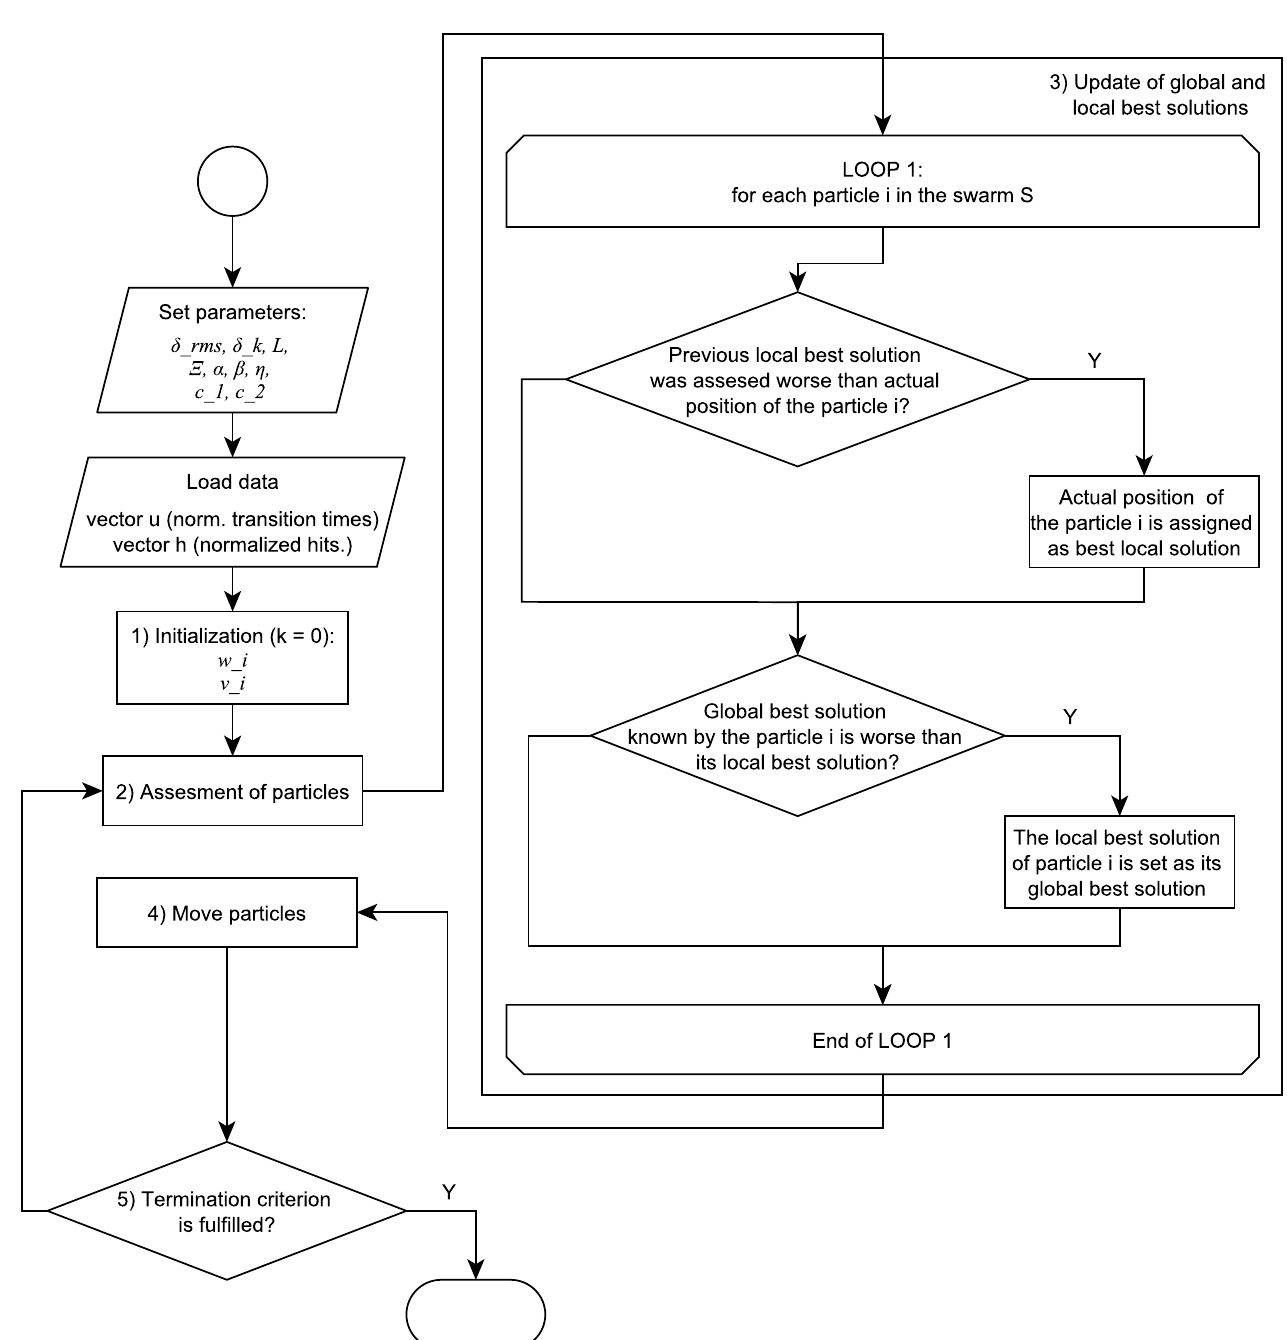
Figure 4. The flowchart presenting the algorithm of modified Particle Swarm Optimization for a single Fig. 5: The flowchart presenting the algorithm of mPSO for a single swarm